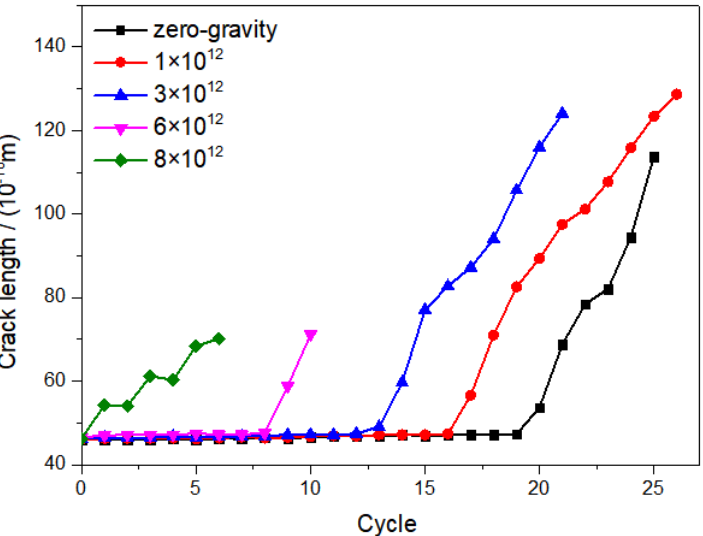
Figure 7. Crack length as a function of cycle number under different hyper-gravity intensities at 300 K.